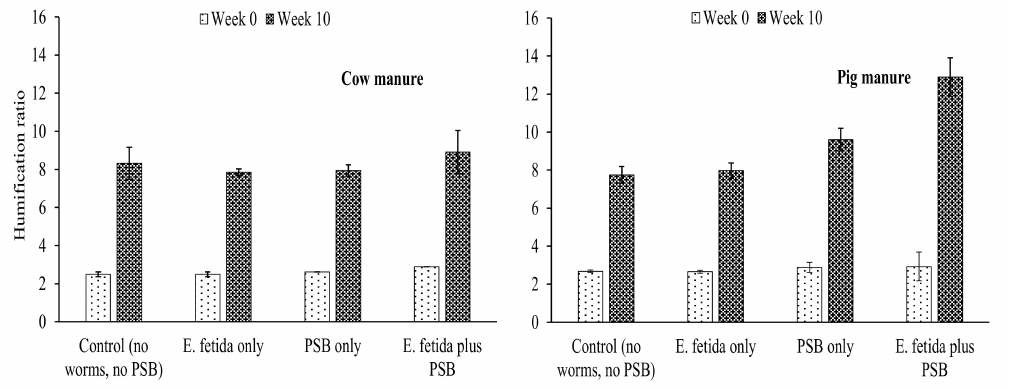
Figure 3. E ff ect of E. fetida and P. fluorescence on the humification ratio during the vermicomposting of RP-enriched cow and pig manure waste paper mixtures. Error bars indicate standard